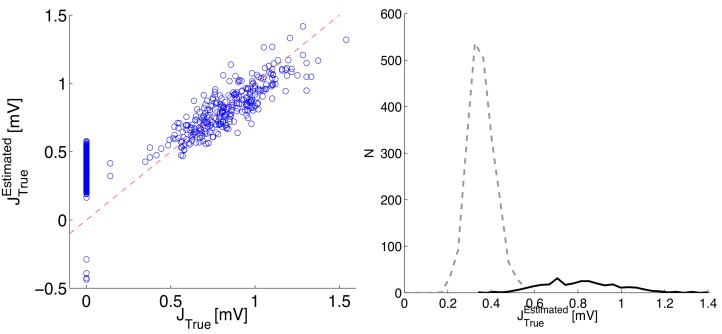
Inference results for the Kinetic Ising Model with time delays for the network described in Fig. 7; all the details are as in Fig. 8, with the exception that the inference procedure is carried out considering only the inter-burst (low activity) periods during a recording time of 2 hours only (about 1/5 of the recording length used in Fig. 8).Delays inferred from the cross-correlation peaks vs actual delays for existing synapses have R
2 = 0.944 with the identity line.